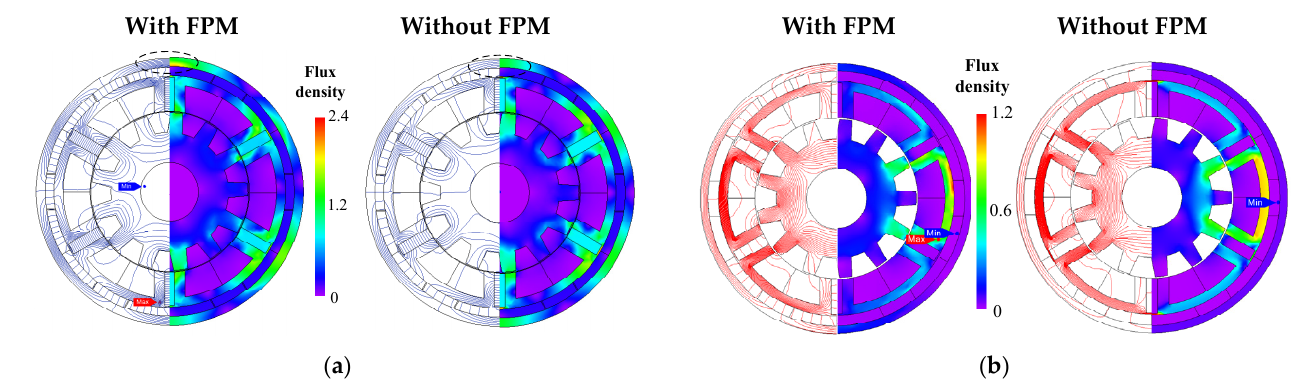
Figure 4. On-load demagnetization effect: field distributions excited by ( a ) NdFeB only and ( b ) armature reaction only.